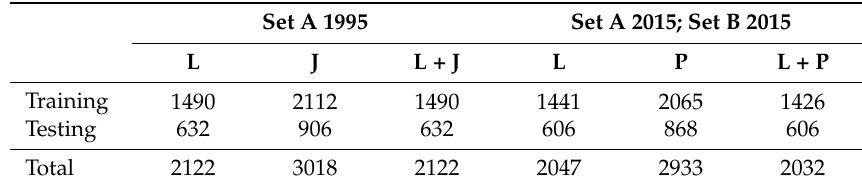
Table 3. Number of pixels used as training and testing pixels for classification. Note that L = Landsat; J = JERS; P = PALSAR; and L + J and L + P indicate combined Landsat and SAR